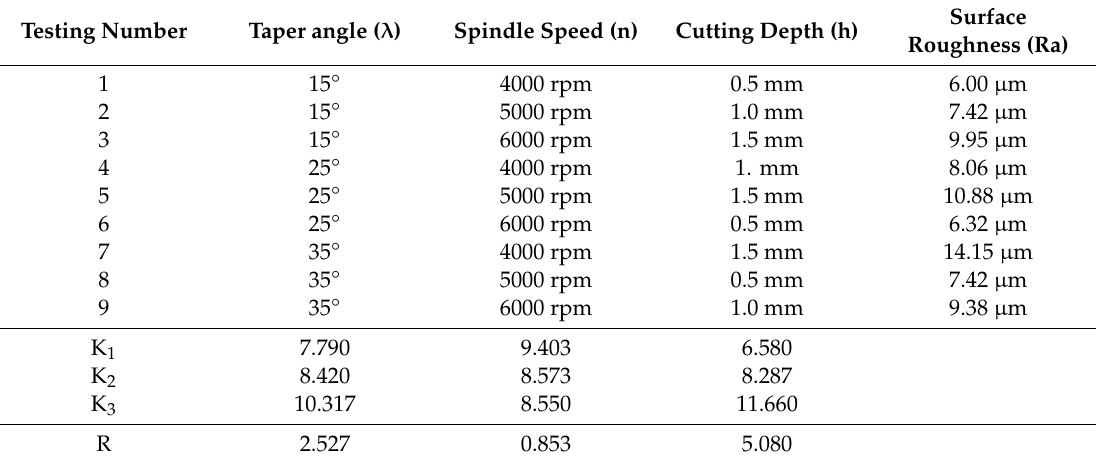
Table 6. Range analysis of surface roughness